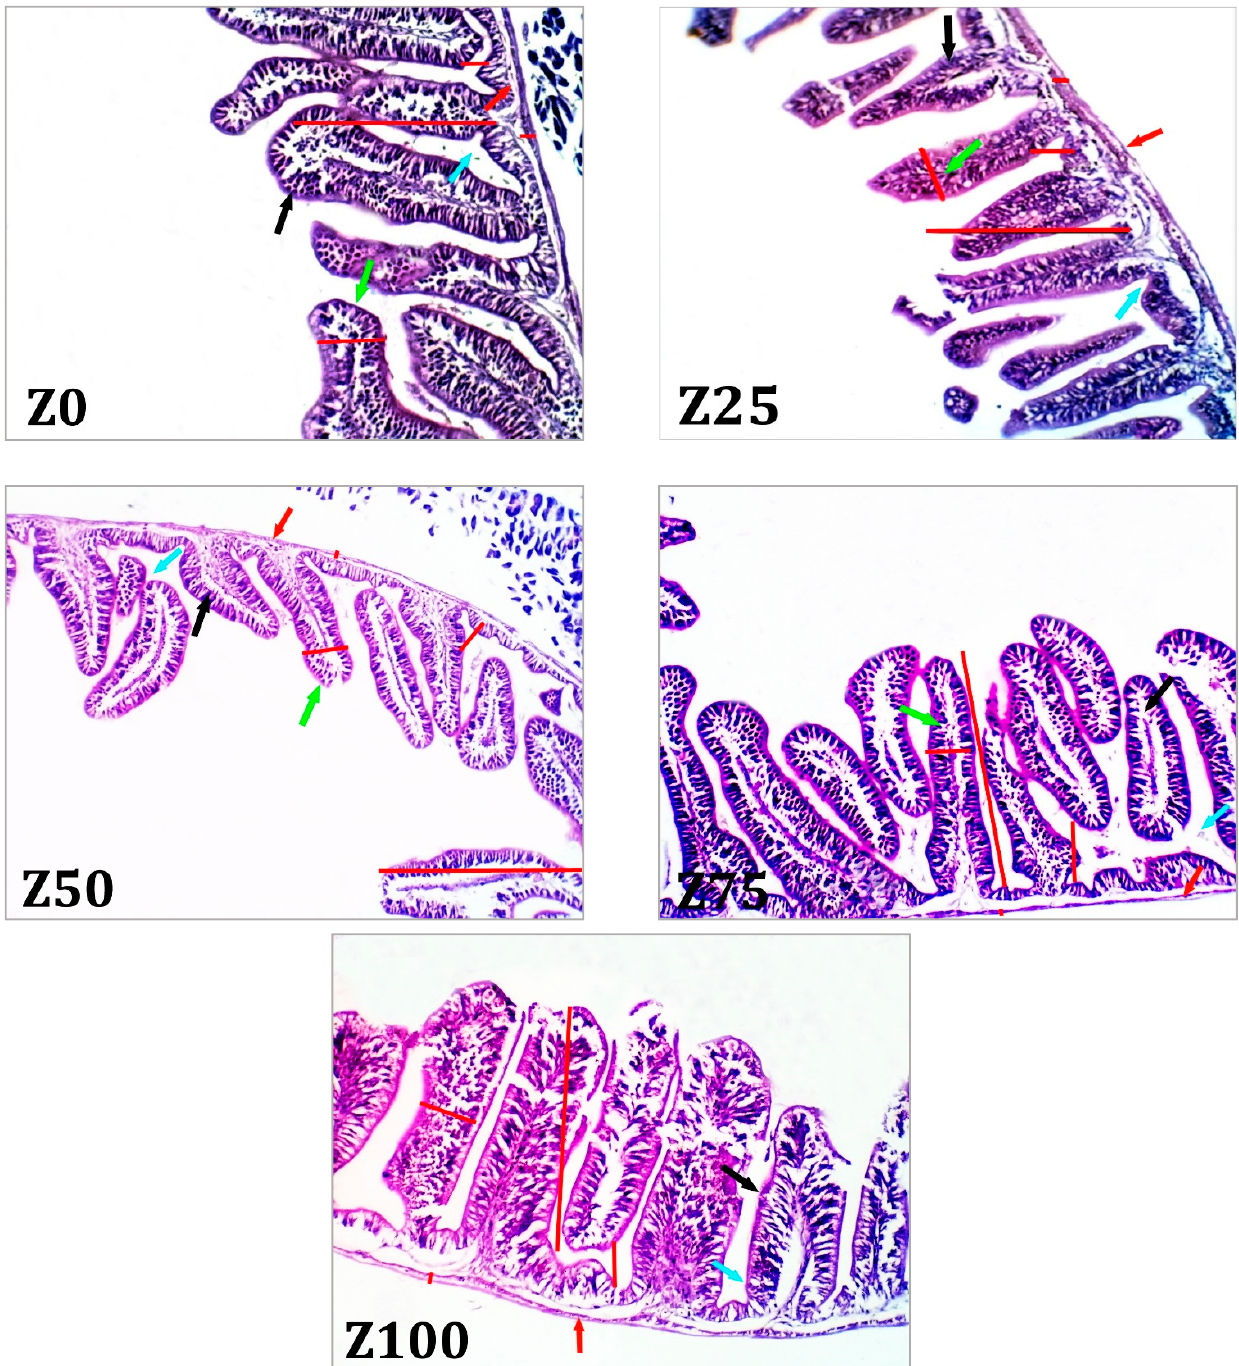
Figure 2. Photomicrograph from intestine of the control (Z 0 ) group showing normal histo-morphological structures of the villi and intestinal whale. The increase in ZBM levels show a comparatively increase in both villous length, crypts length and muscle thickness, with a characteristic increase in the number of goblet cells. Villous length (black arrow), crypt depth (blue arrow), villous width (green arrow), and muscle thickness (red arrow). Z 0 = diet without zooplankton biomass meal (ZBM) inclusion; Z 25 , Z 50 , Z 75 , and Z 100 have 25, 50, 75, and 100% fishmeal replaced with ZBM, respectively.